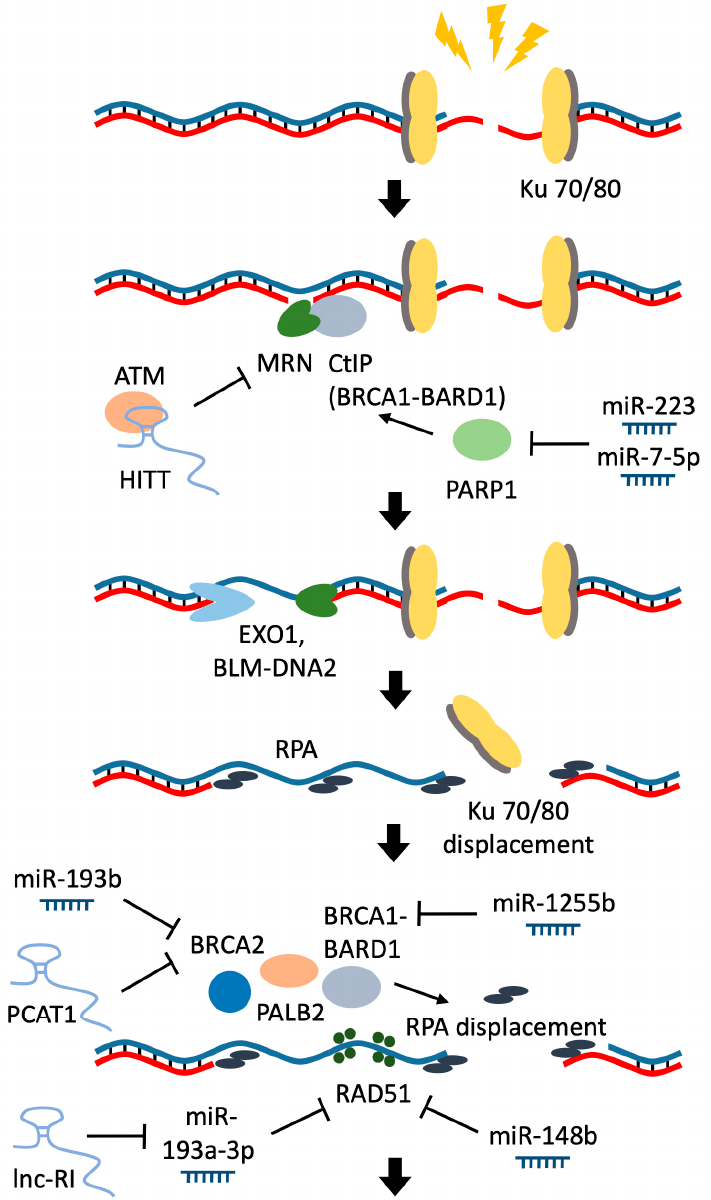
Figure 4. RNAs that regulate homology-directed repair (HDR) during the resection of 5 (cid:48) -ends and replication protein A (RPA) displacement. LncRNA HITT disrupts the ability of ataxia telangiectasia mutated protein kinase (ATM) to bind with the MRN complex, leading to reduced HDR. MiR-7- 5p and miR-223 decreased the expression of the poly-(ADP-ribose) polymerase (PARP1). PARP1 through the breast cancer type-1 susceptibility protein (BRCA1) and BRCA1 associated RING domain 1 (BARD1) complex controls the work of the CtIP endonuclease. After activation of this nuclease, the resection is expanded by exonuclease 1 (EXO 1) with the help of bloom syndrome helicase (BLM) and DNA Replication helicase 2 (DNA2). RPA binds to single-strand DNA, and it is displaced by BRCA2 and BRCA1-BARD1 with the help of Partner and localizer of BRCA2 (PALB2). Expression of BRCA1 and BRCA2 is controlled by miR-1255b and miR-193b, respectively. Expression of BRCA2 is also suppressed by lncRNA prostate cancer-associated transcript 1 (PCAT1). Protein RAD51 is necessary for 3 (cid:48) strand invasion and passing further stages of HDR. Expression of RAD51 is controlled by miR-148b and miR-193a-3p. The activity of the last miRNA is suppressed by radiation-induced lncRNA